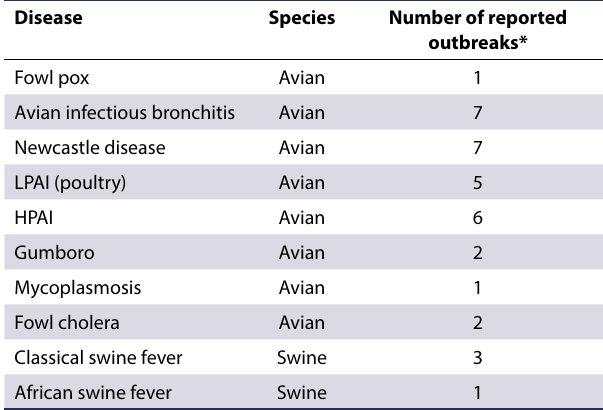
Table IV: List of pig and poultry diseases found in the OIE database (WAHID interface) from 2005 to 2020 (OIE 2020a)